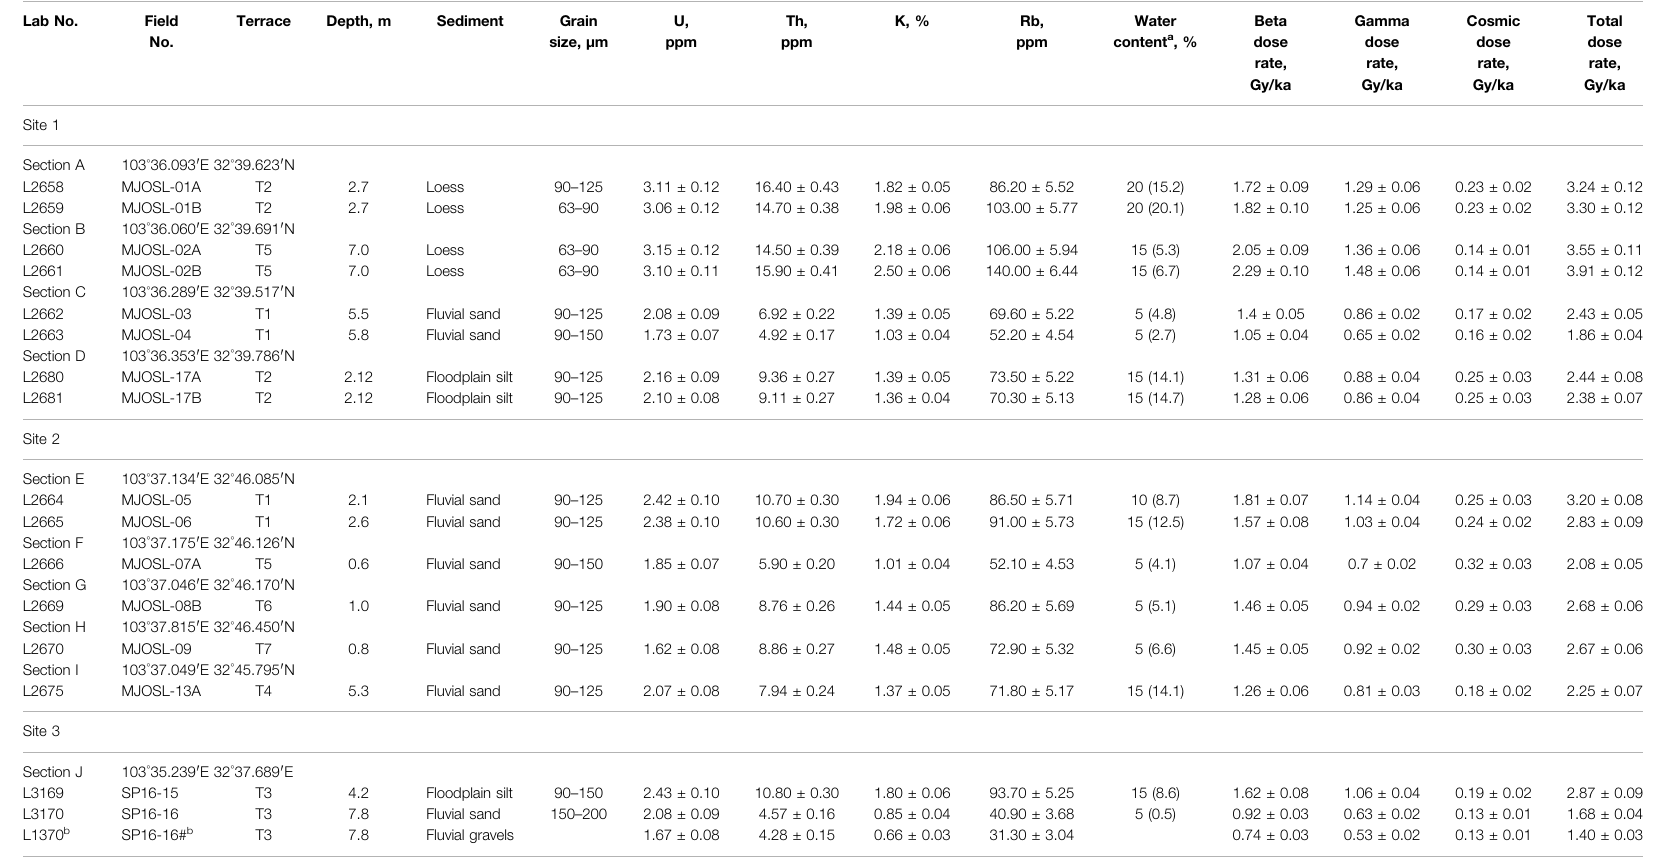
TABLE 1 | Dose rates of the samples from the Minjiang River. Lab